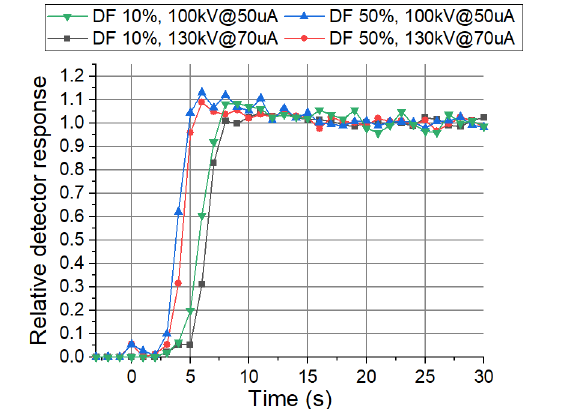
Fig. 7. Relative detector response of Cd-covered detector in moderated geometry to generator start-up for four set-ups at 250 Hz. The pulse stability has been observed for five-minute operation of the tube with various set-ups of pulsing frequencies, duty was summed per five seconds, thus creating 60 batches per each five-minute-long run. The results are given in the figure 8. One output that correspond to the generator start-up. Then, the pulse shapes remained stable throughout the